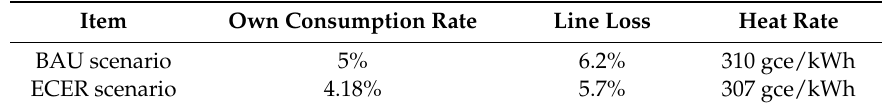
Table 4. Scenarios of China’s power sector to 2020.